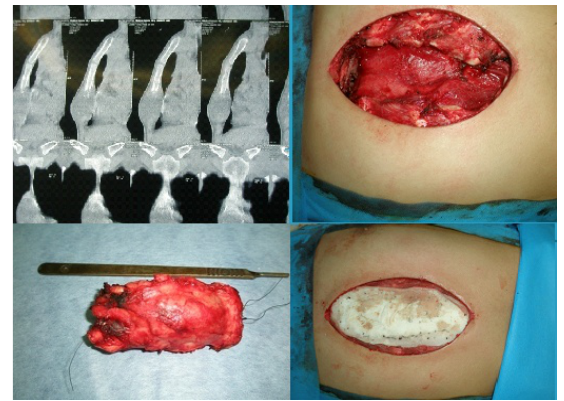
Figure 1: 15 year's old man with sternal liposarcoma, sternum resection and reconstitution with sandwich mesh